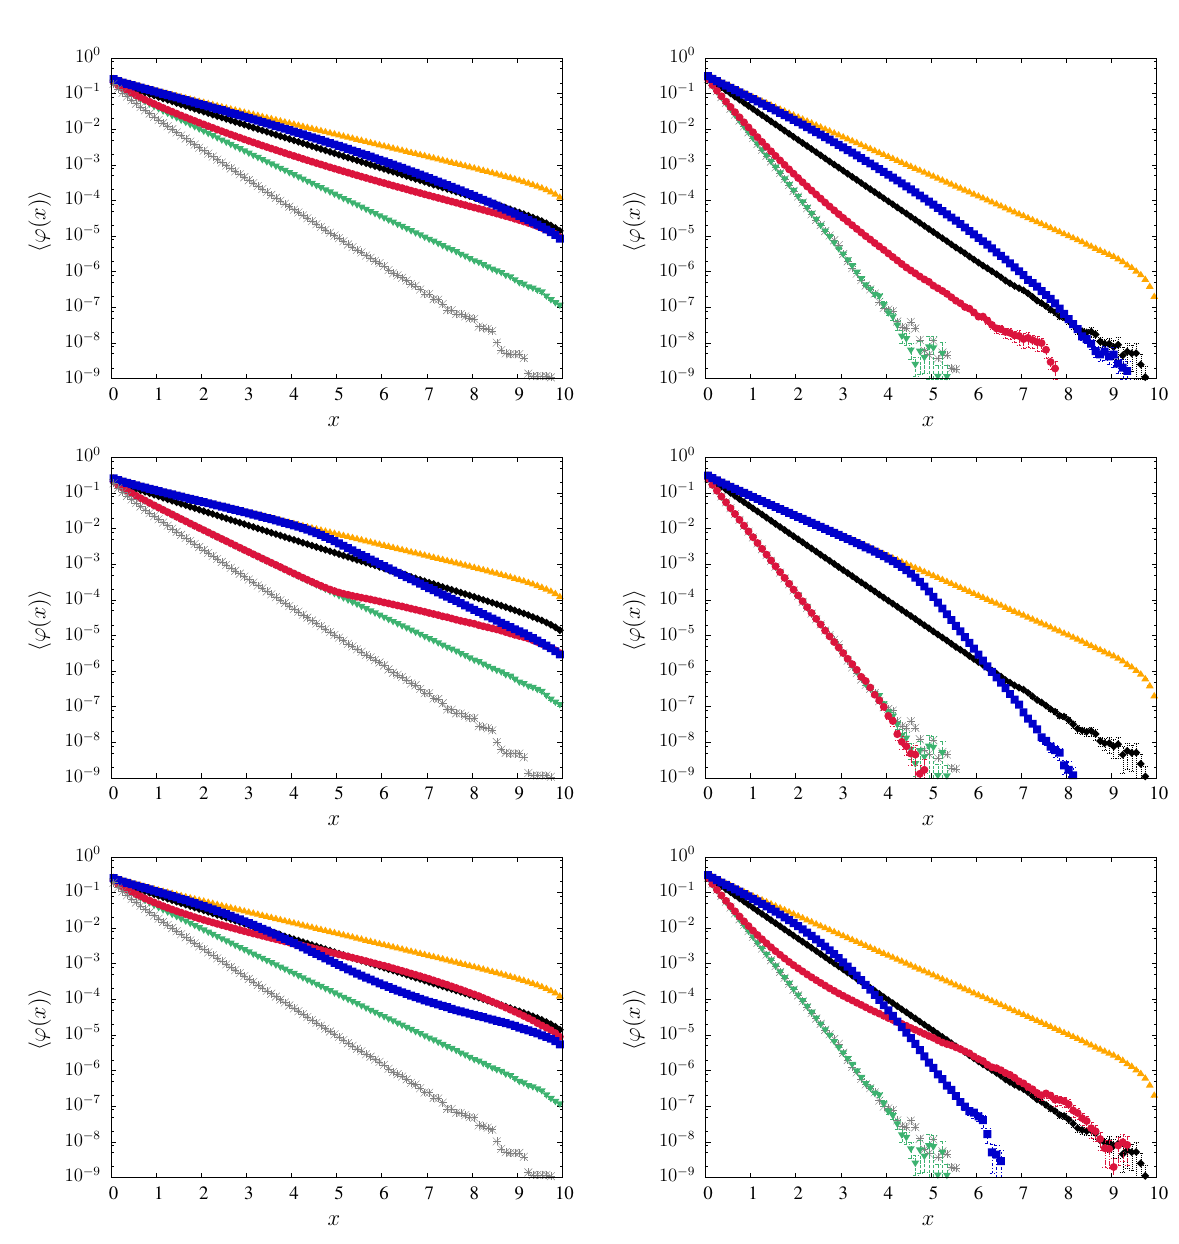
= 10 , for different x